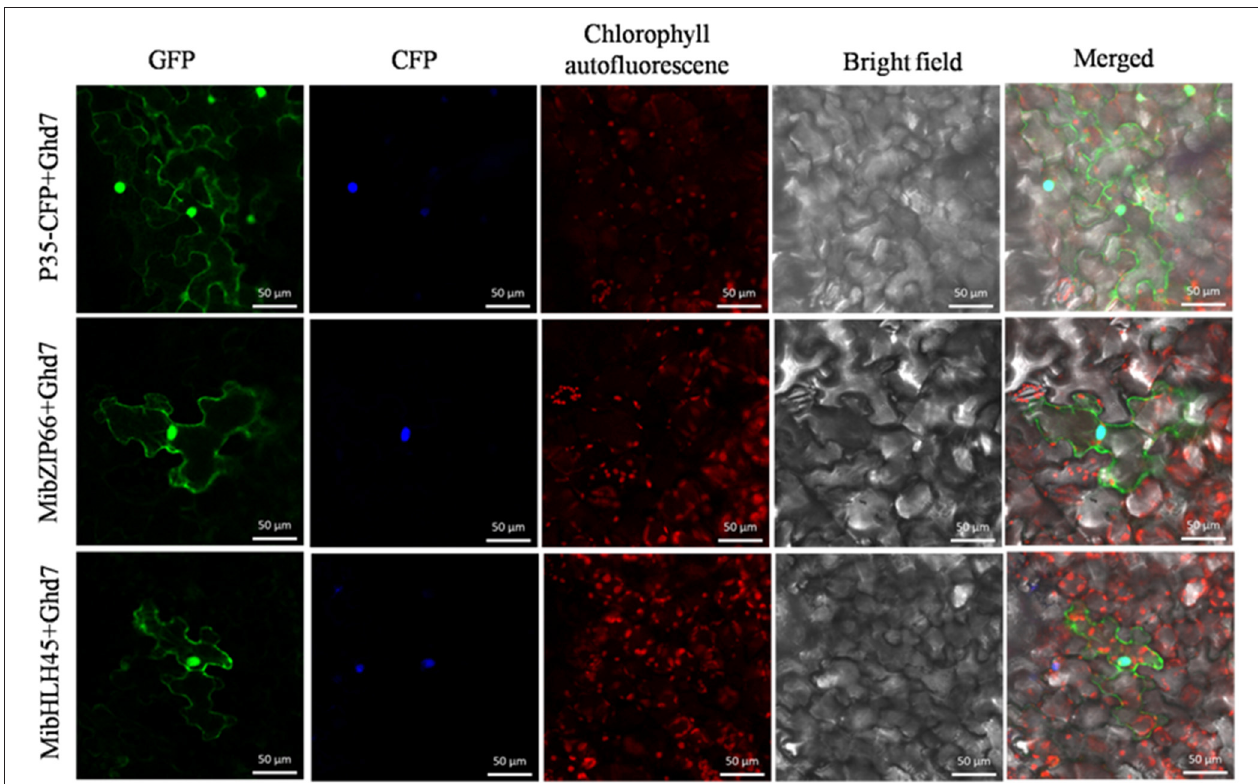
FIGURE 7 | Subcellular location of MibZIP66 and MibHLH45 protein in tobacco ( N. benthamiana ) leaf epidermal cells. The nuclear localization signal-CFP-transformed tobacco epidermis cells served as nuclear markers. The green fluorescence protein was examined at 24h after inoculation. Bars = 50 µ